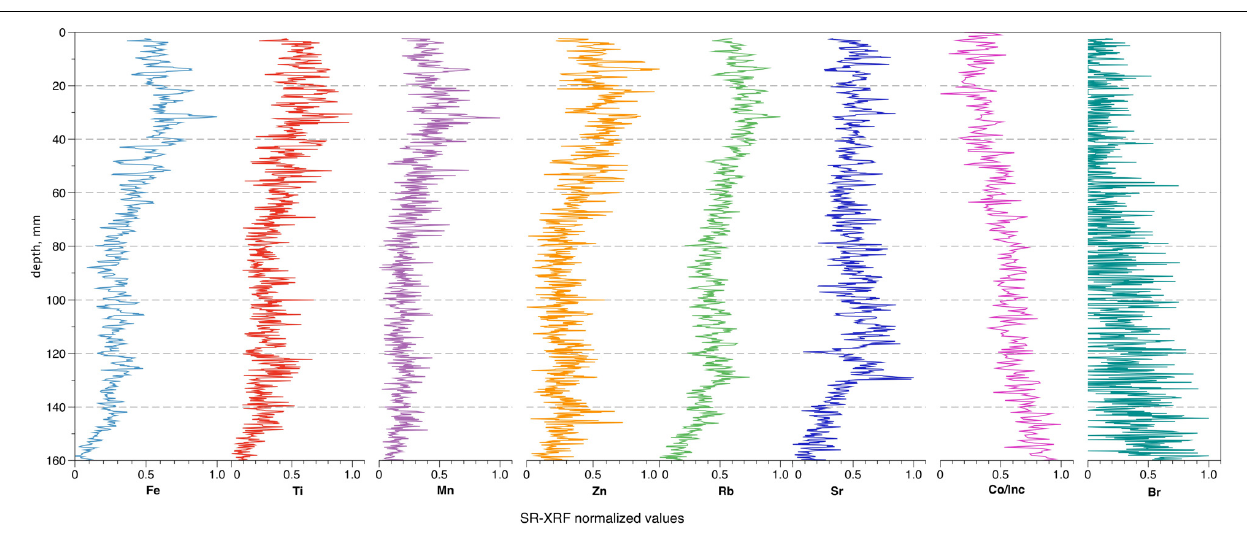
FIGURE 4 | Results of the high-resolution SR-XRF scanning analysis (upper 160 mm, normalized